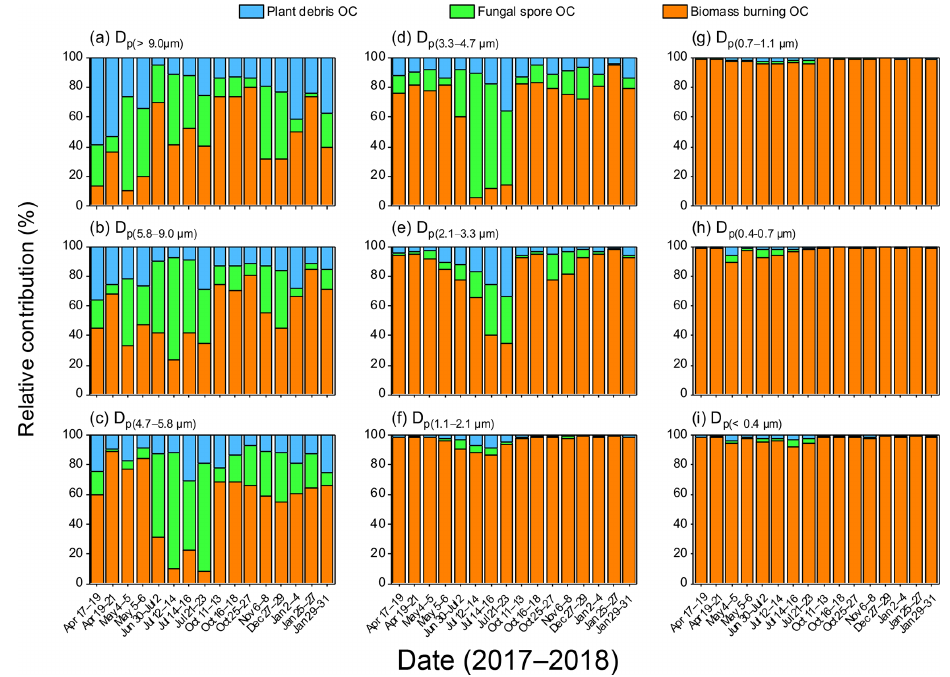
Figure 10. Relative contributions of plant-debris-derived OC, fungal-spore-derived OC and BB-derived OC in different size ranges of urban aerosols in